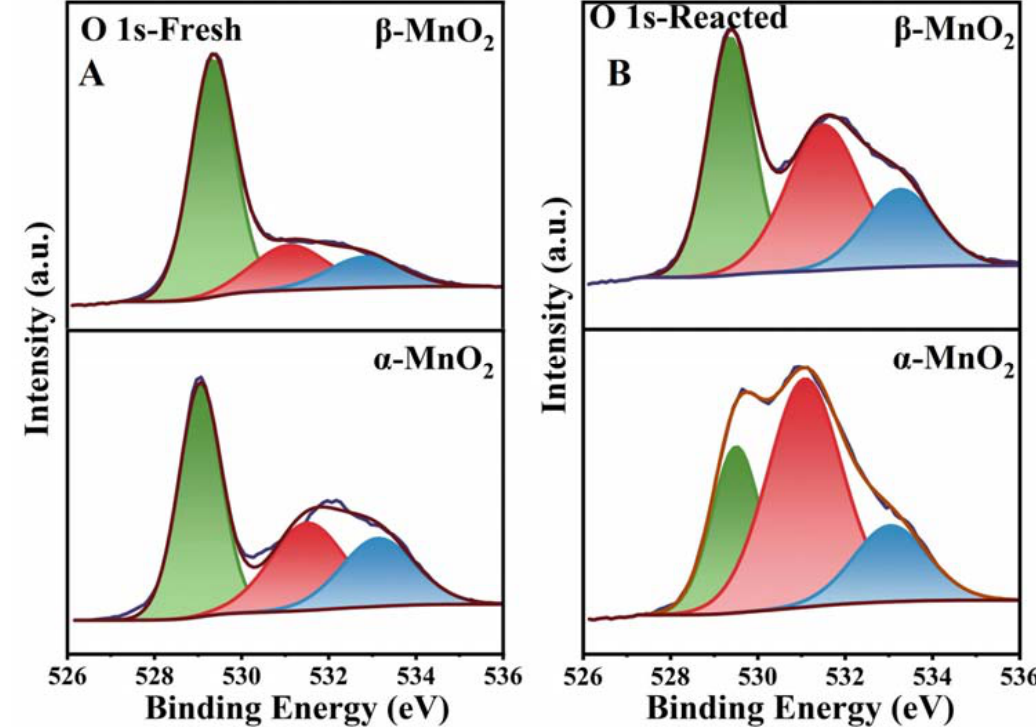
Figure 11. XPS profiles of O 1s over the fresh ( A ) and spent ( B ) catalysts. Table 2. O 1s results before and after the reaction of B-MnO 2 and C-MnO 2 .